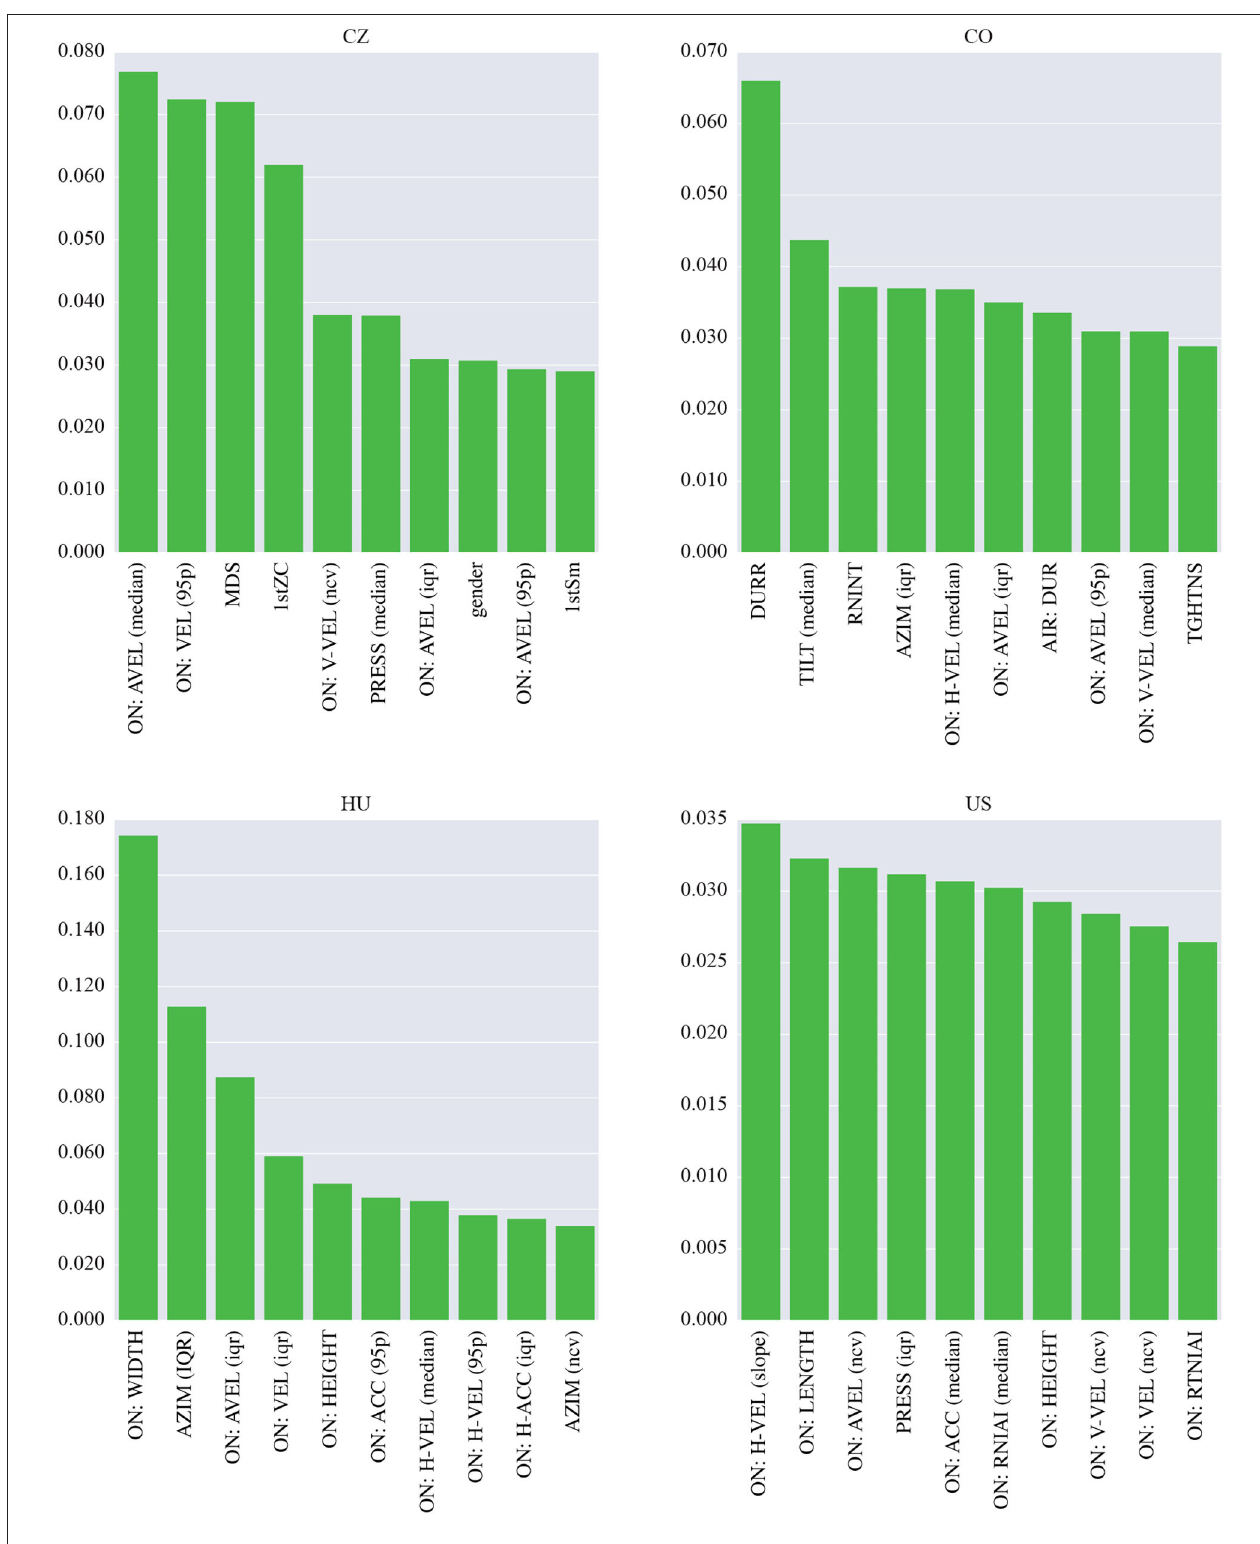
FIGURE 2 | Importance of the features used in the models in the single-language scenario (spiral drawing task).